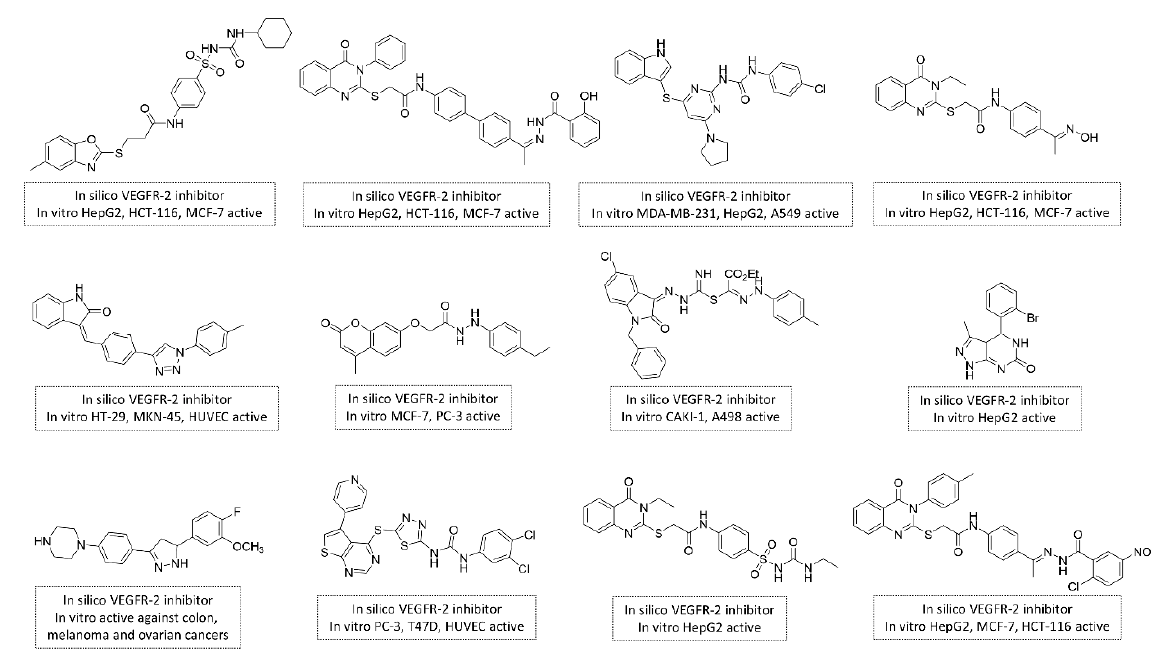
Figure 1. Recently reported drug candidates that proved to inhibit VEGFR-2 and emerged as effective molecules against various cancers.